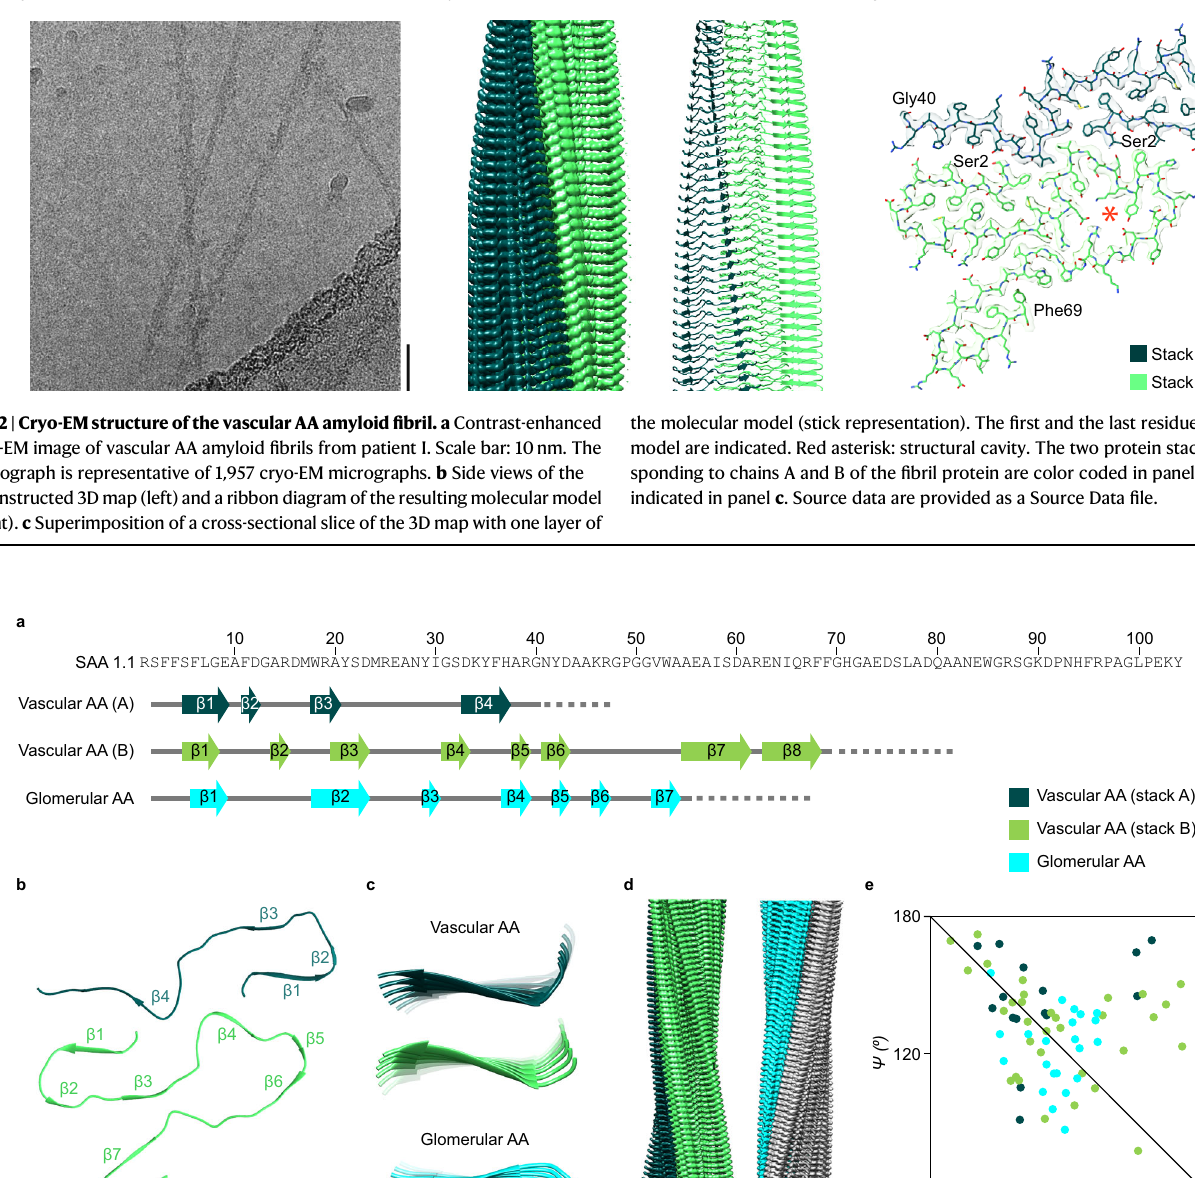
fi brilaxisisshown. d Sideviewsofthe3Dmapsofthevascular(left)andglomerular fi bril(right). e Ramachandranplotoftheresiduesinthe β -sheetsofthevascularand glomerular fi bril.Thedatafortheglomerular fi brilswereplotted based onthePDB entry 6MST [https://www.rcsb.org/structure/6MST] 13 . The color coding is con- sistent in all panels, as explained in panel e . Source data are provided as a Source Data fi